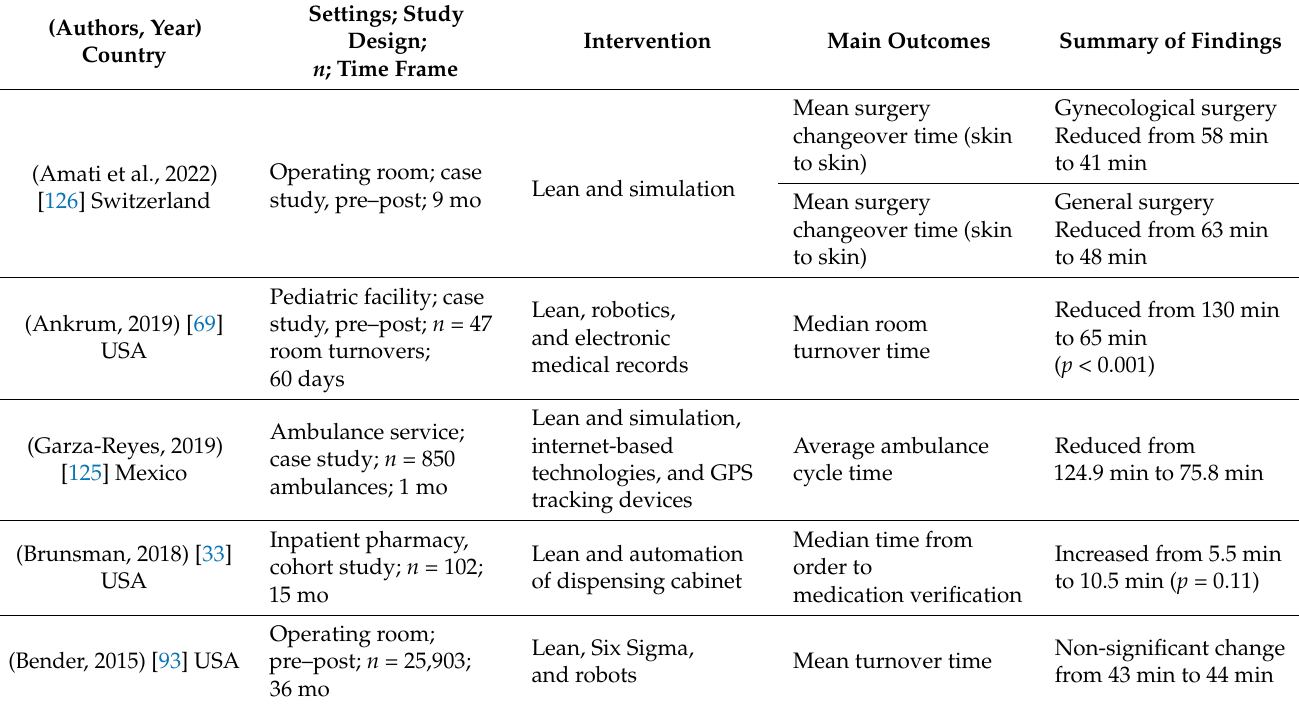
Table 5. TOT outcomes of LH interventions supported by